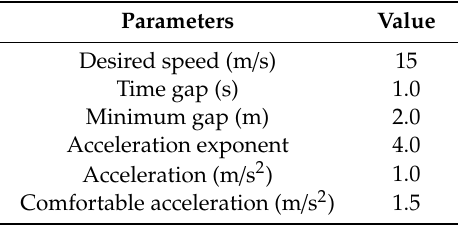
Table 1. Typical parameters of an intelligent driver model (IDM) controller for city tra ffi